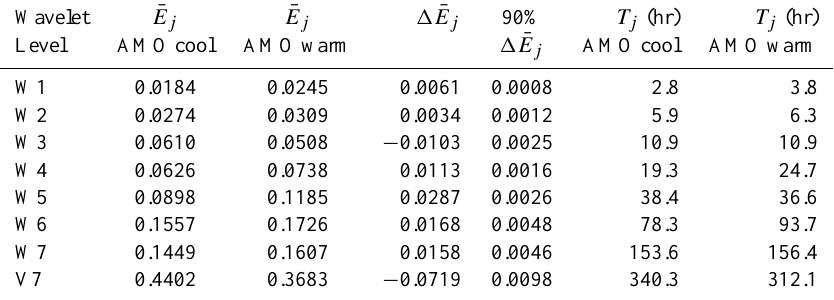
Table 3. NTR event relative energy and temporal periods at Key West.